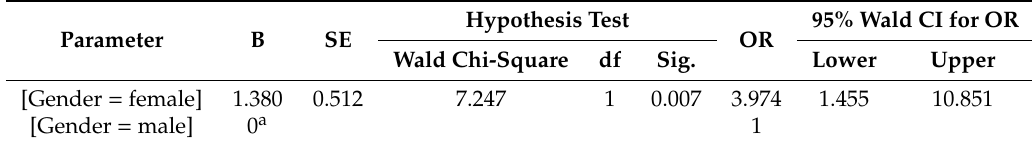
Table 2. Ordinal Logistic Regression model result predicting zookeepers’ scores on the Brambell’s Five Freedoms fulfilment scale. Parameter B SE